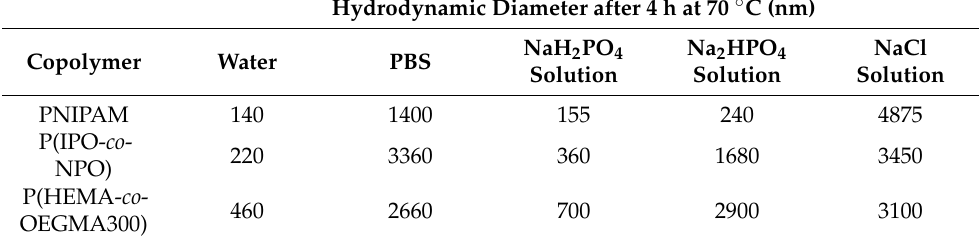
Table 2. Polymeric particles sizes in different solutions after abrupt heating and 4 h of sample annealing at 70 ◦